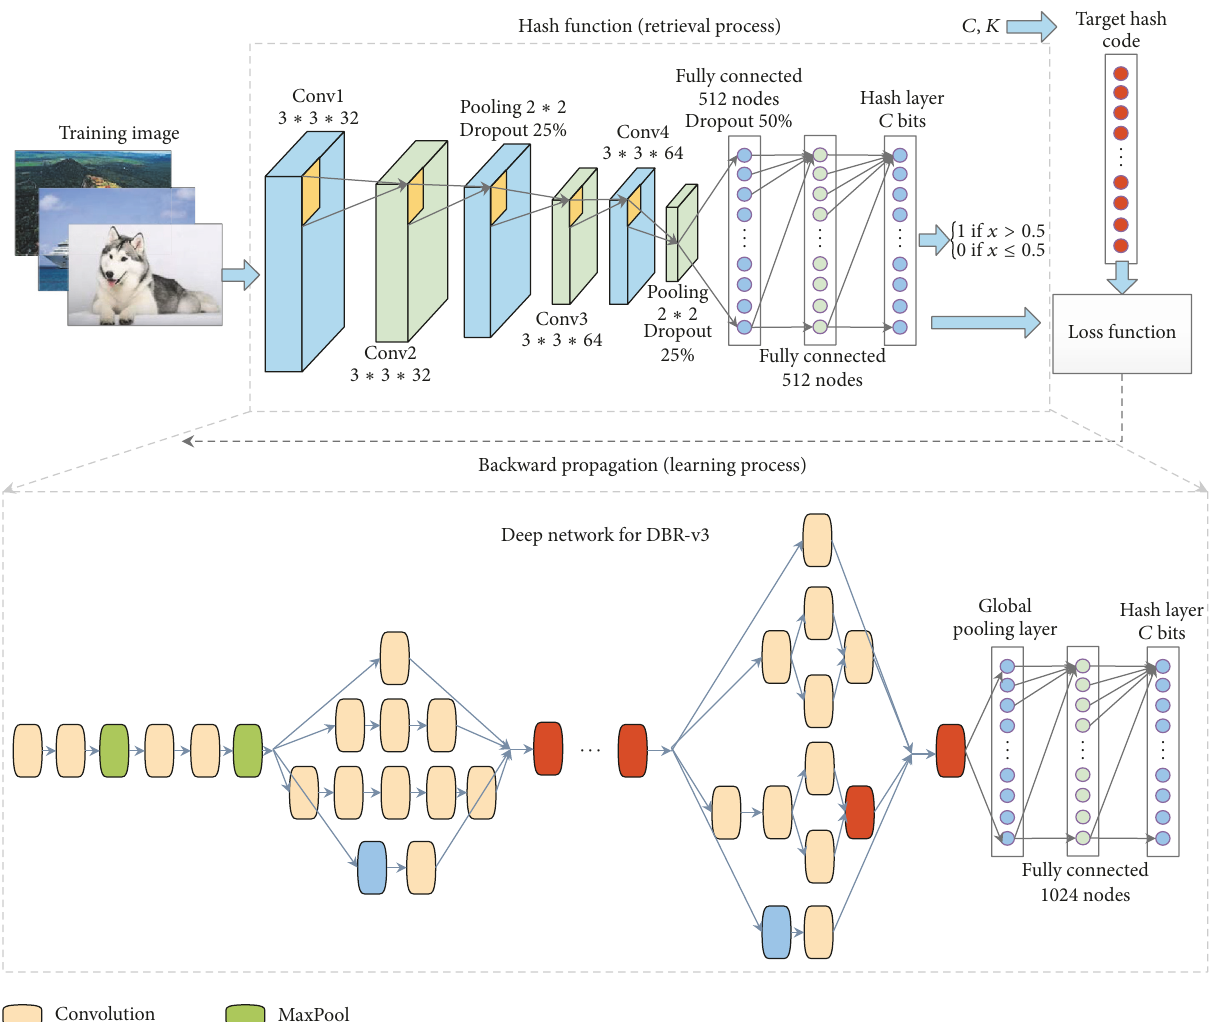
Figure 2: The CNN network of our proposal. The upper part is the DBR network, and the lower one is the DBR-v3 network based on inception-v3 net. First, target hash code set is generated based on hash length 𝐶 and image category number 𝐾 . Then deep network is trained with raw images and target hash code. Finally, image retrieval is processed with the hash function, which is the trained network concatenated with a sgn